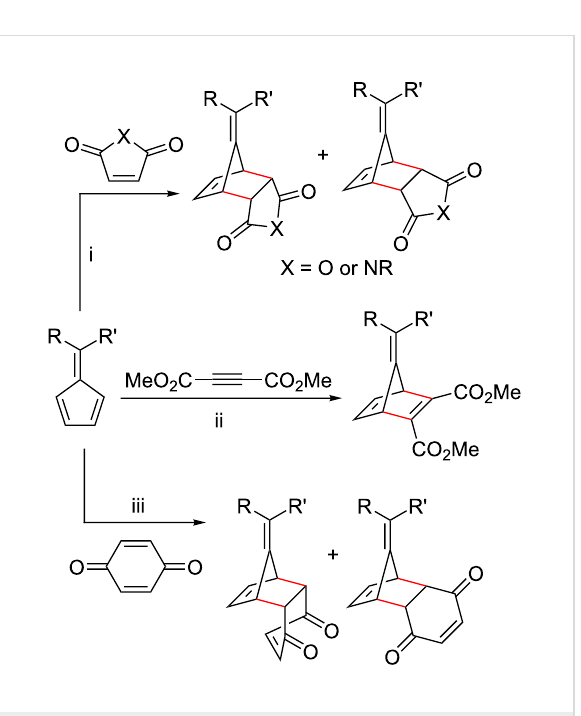
Scheme 14: Diels–Alder cycloaddition of pentafulvenes derivatives participating as dienes with (i) maleimide derivatives, (ii) dimethyl acetylenedicarboxylate (DMAD) and (iii)